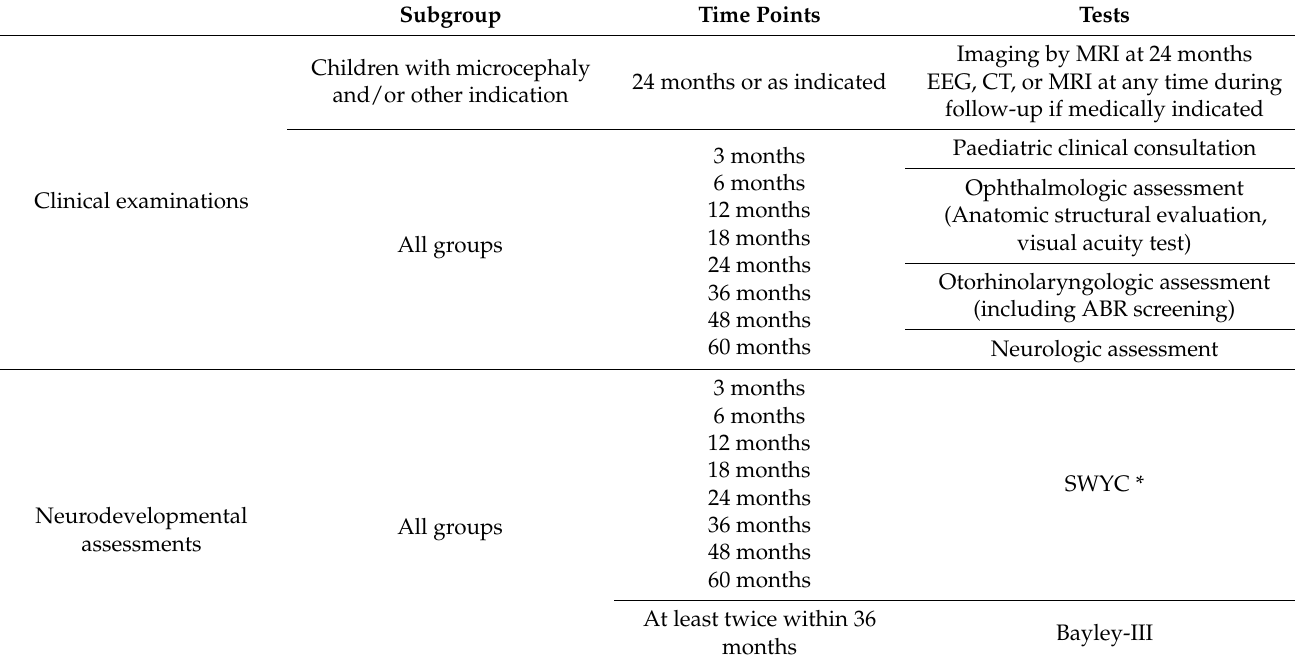
Table 3. Follow-up assessments in the children’s cohort from